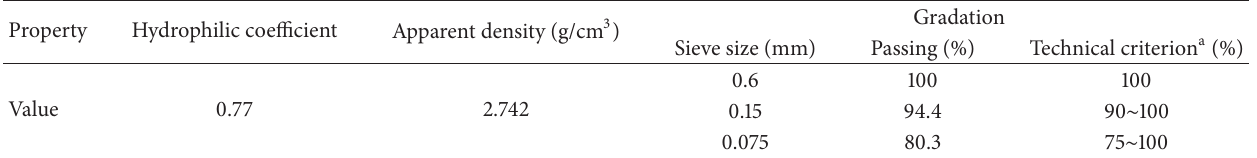
Table 4: Physical properties of mineral powder.